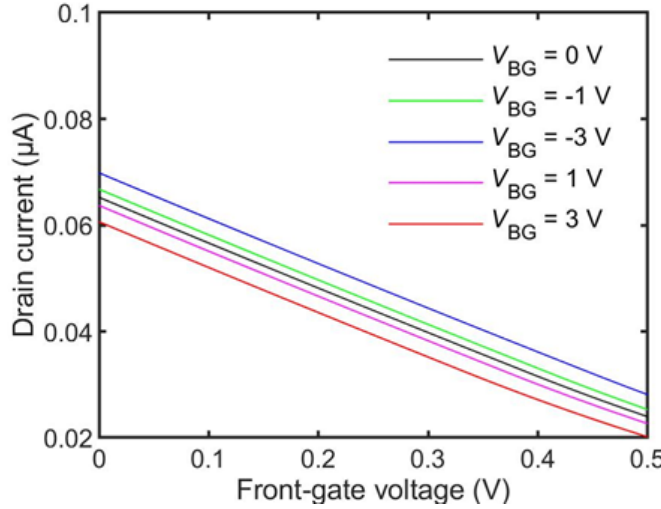
Figure 7. Drain current as a function of front-gate voltage with different back-gate voltages [ V BG ] for the accumulation-mode PPy p-type channel transistor sensor. The curves were calculated by analytical modeling in ref. [28] and the parameters are given in the text.